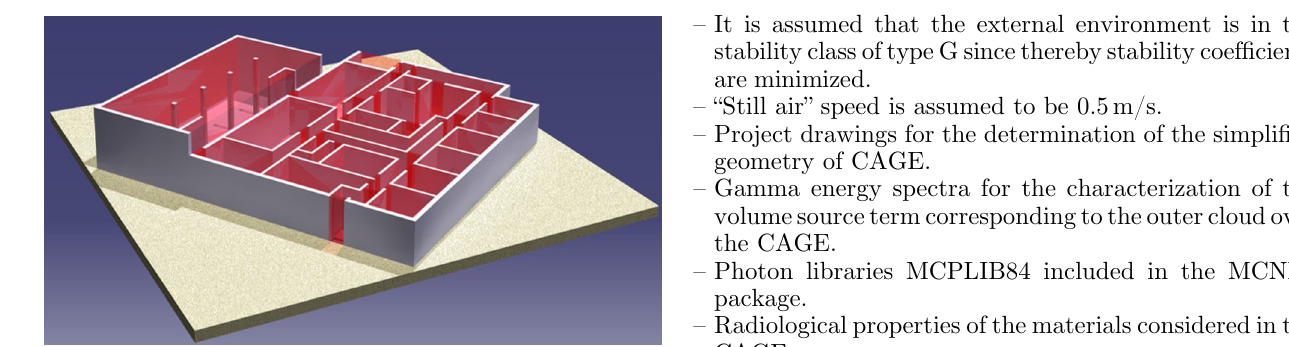
Fig. 3. Simpli fi ed